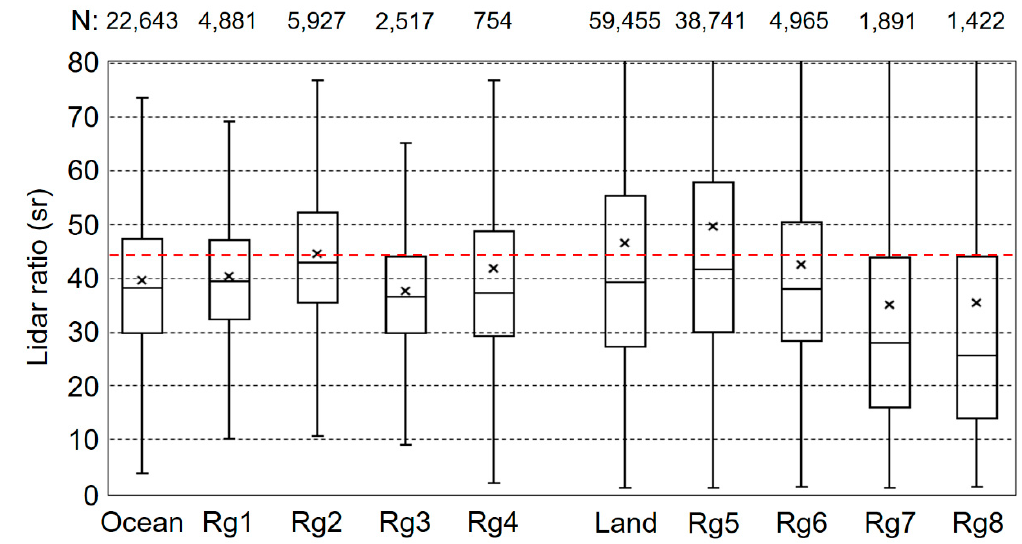
Figure 6. Box-whisker plots of retrieved lidar ratio over ocean, land and for regions shown in Figure 5. Boxes are for 50% percentile, bars and x-marks in each box are median and mean values, respectively. Red dashed line represents 44 sr that is used in the CALIOP version 4 aerosol retrieval algorithm. The number of data (N) is shown on the top.